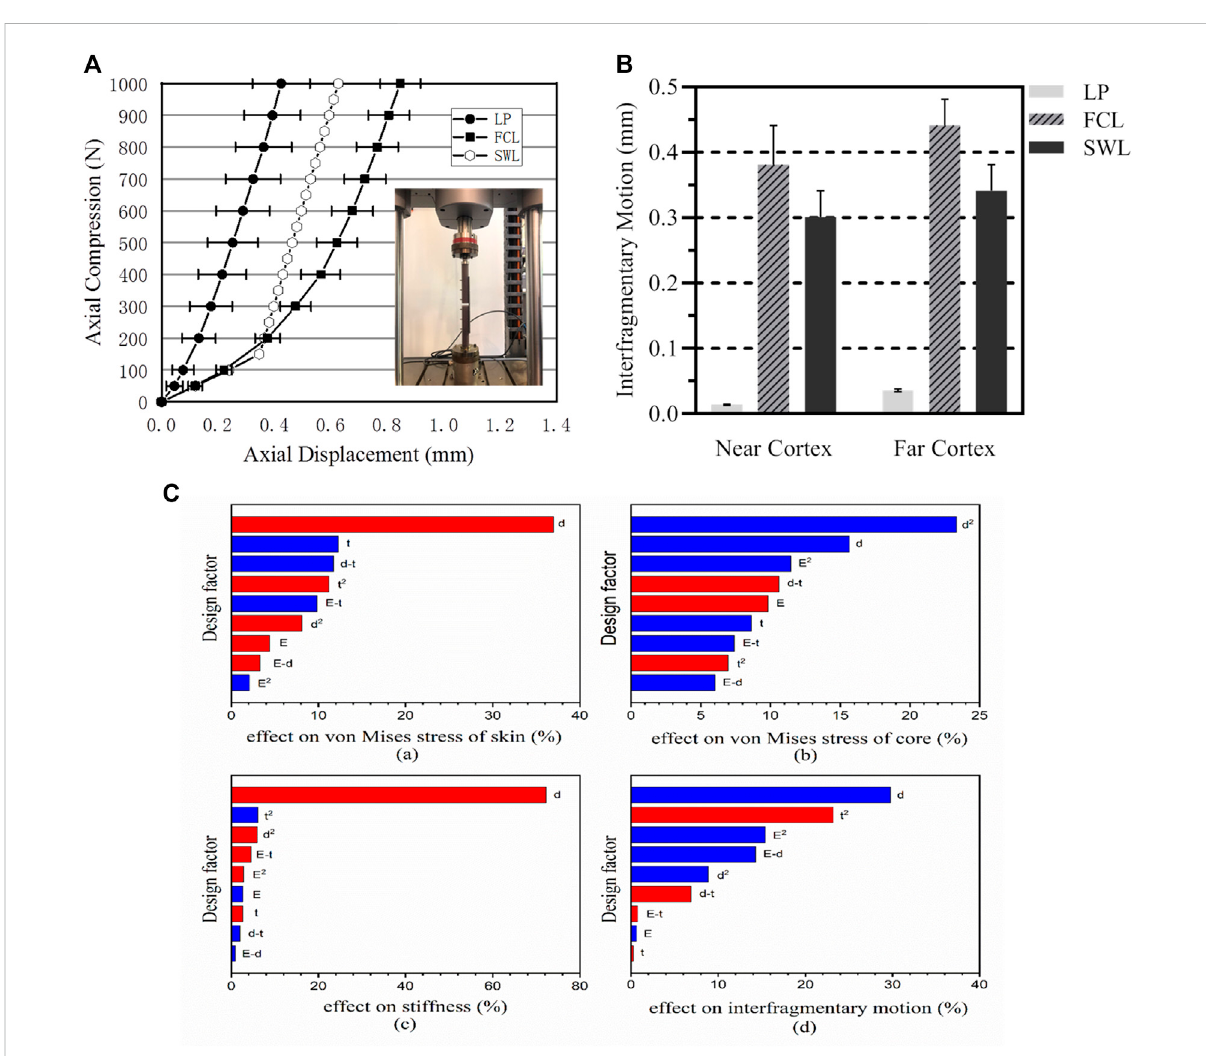
FIGURE 4 Structuraldisplacementanalysis. (A) Comparisonofthestiffnessofthethreestructuresinthenon-osteoporoticmodelinaxialcompression. (B) At 150 N of loading, the initial stiffness of three constructs induced comparable amounts of interfragmentary motion at the near and far cortex. LP: Locked plating constructs; FCL: Far cortical locking constructs; SWL: Sandwich locking constructs. (C) Factor sensitivity analysis of each design